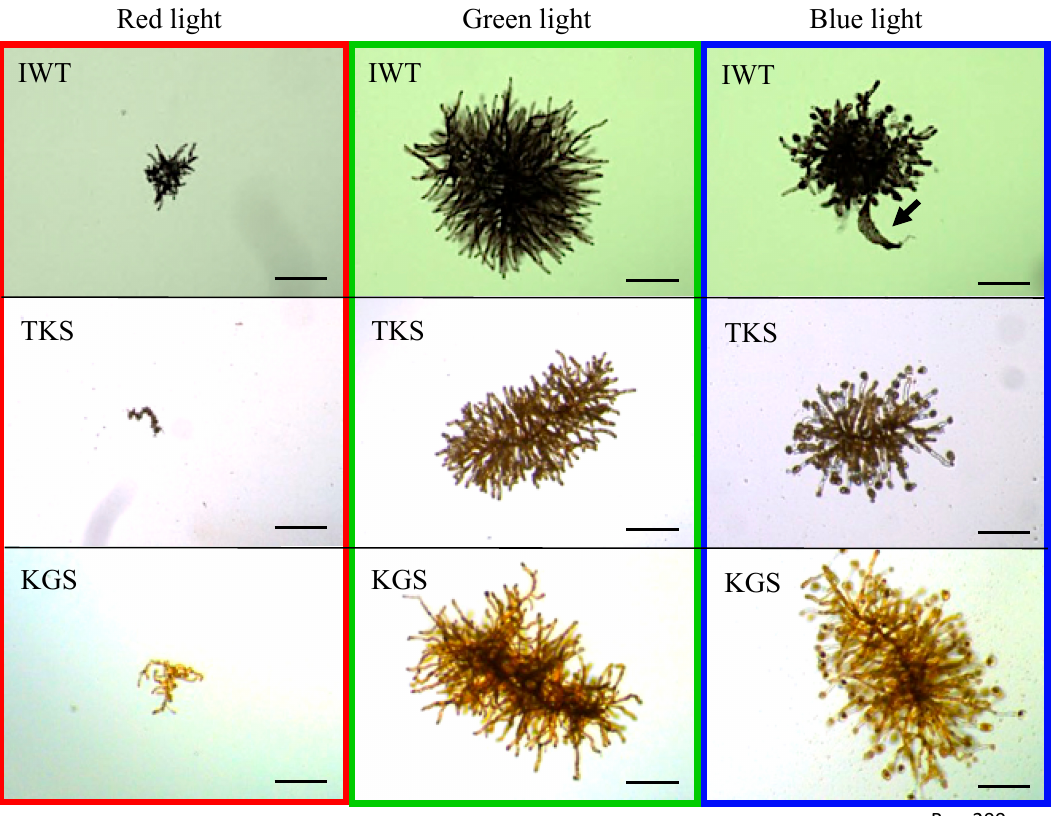
Figure 3. Photographs of representative female gametophytes from the three regions (IWT—Iwate, TKS—Tokushima, KGS—Kagoshima), cultured for 25 days under different wavelengths of light. As a representative condition, these gametophytes were cultivated at 40 µmol m − 2 s − 1 and 20 °C under each light color. Scale bars 200 µm. The arrow on the IWT image in blue light indicates sporophyte formation.